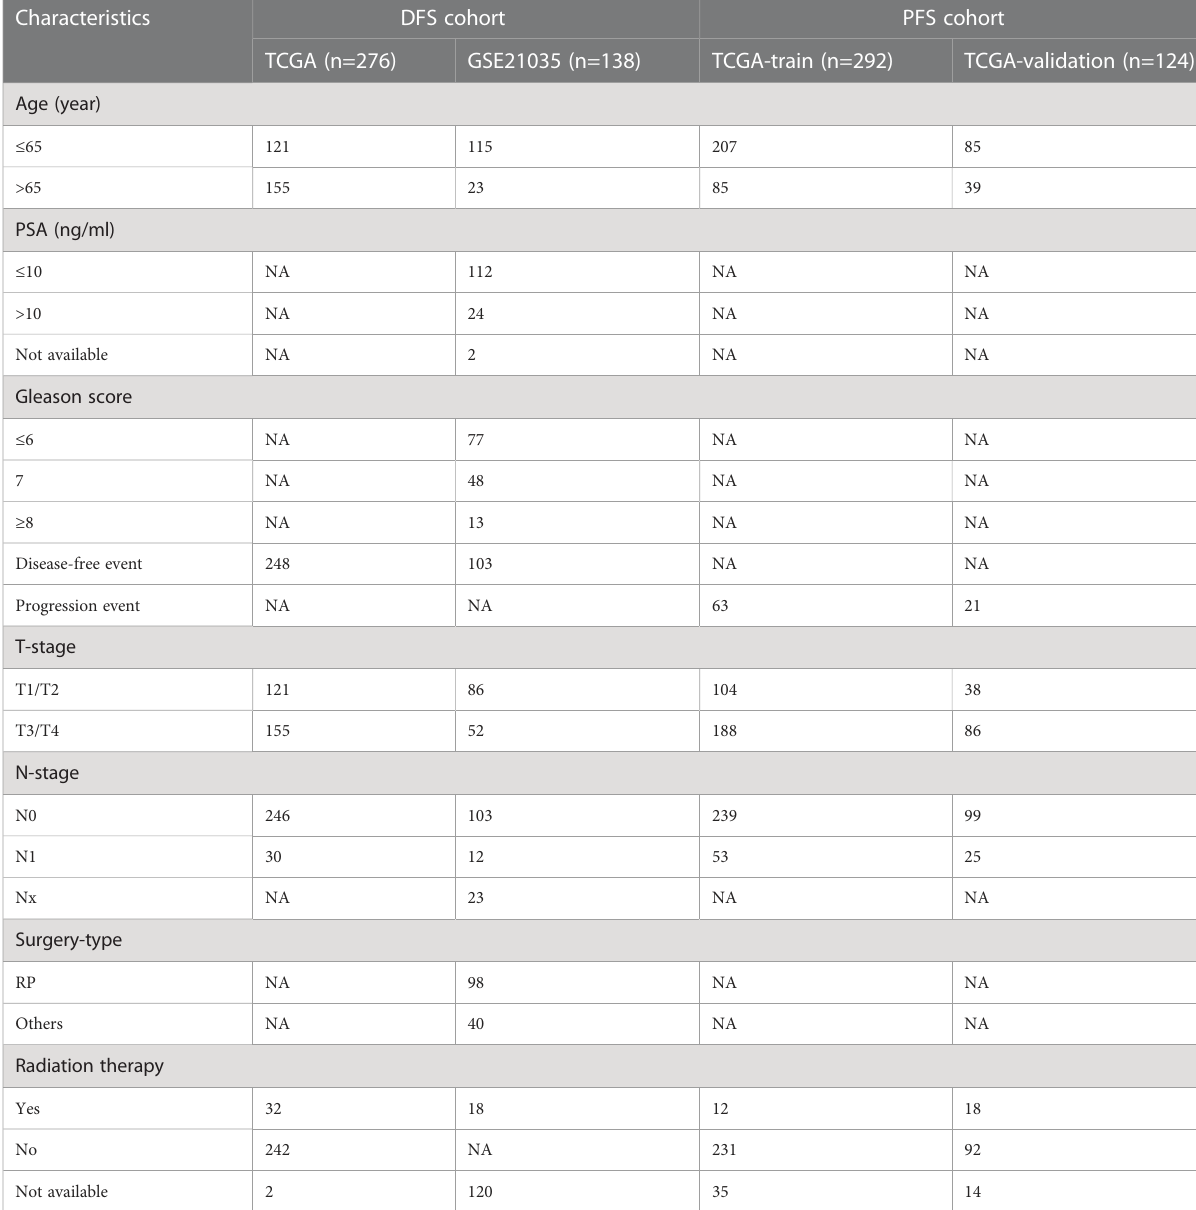
TABLE 1 Characteristics of sample cohorts used for the analysis of DFS as well as PFS.